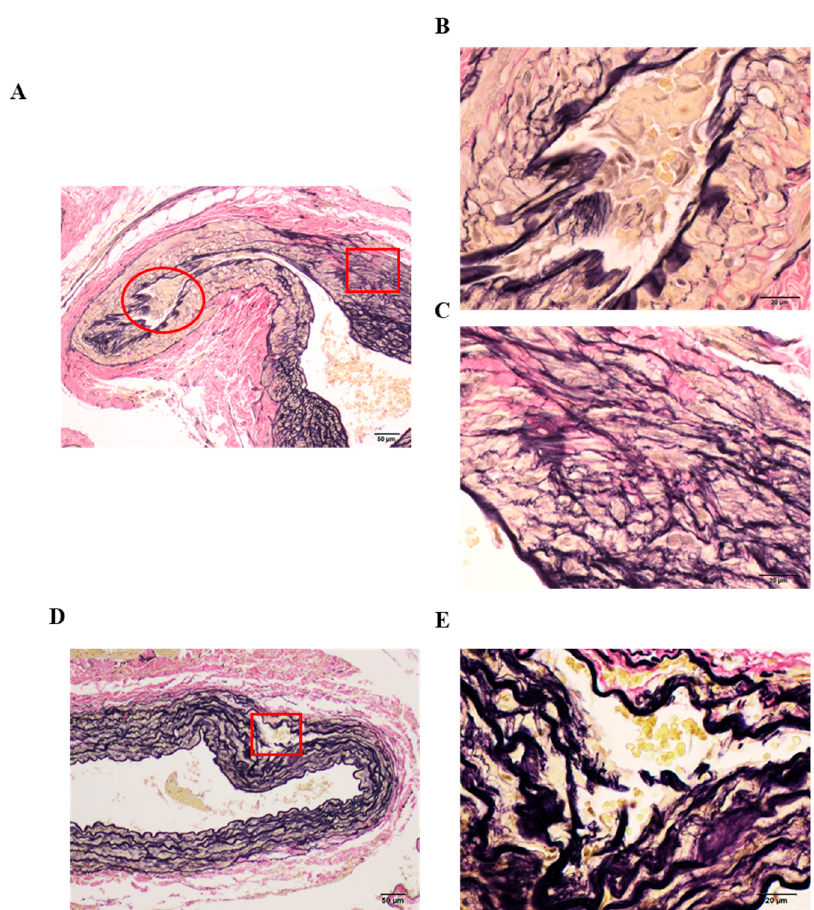
Figure 4. Representative images of pathological vascular remodeling in Elastica van Gieson-stained tissues of OVX Control rats. ( A , D ) Low magnification (100×, scale bar = 50 μ m); ( B , C , E ) high magnification (400×, scale bar = 20 μ m), magnification of the boxed areas in ( A , D ). ( B ) high magnification of the red circle area; ( C ) high magnification of the red boxed area in ( A ); ( E ) high magnification of the red boxed area in ( D ). OVX, ovariectomized.